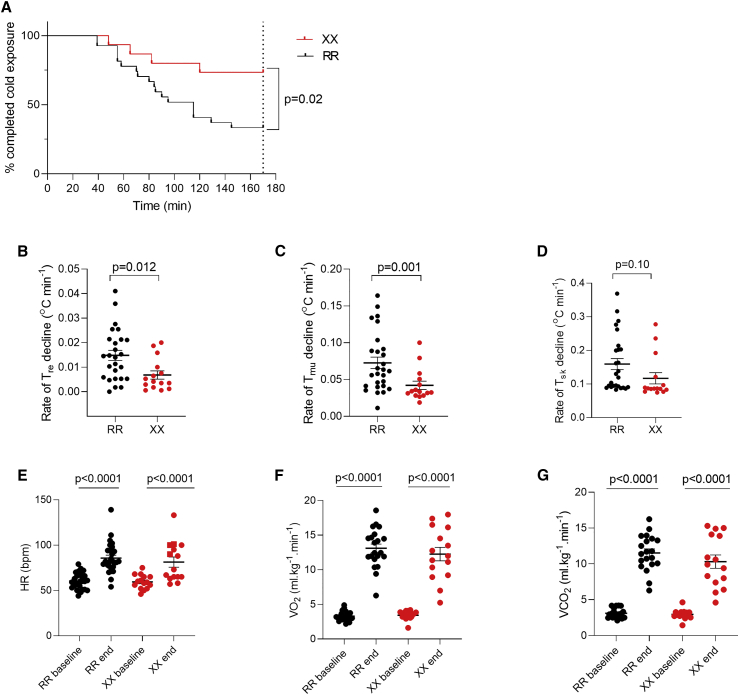
Temperature measurements and physiological responses during cold-water immersion(A) Survival plot of the time taken to reach a rectal temperature (Tre) of 35.5°C or sustaining the complete 170 min period of cold-water immersion in RR (n = 27) and XX (n = 15) individuals. Log-rank (Mantel-COX) test was used to assess statistical difference between RR and XX individuals.(B–D) The decline rate in rectal (Tre), intramuscular (Tmu), and skin (Tsk) temperatures in RR and XX subjects. Statistical difference between the two groups was assessed with unpaired t test.(E–G) Heart rate and rate of pulmonary O2 uptake (VO2) and CO2 exhalation (VCO2) before (baseline) and at the end of cold-water immersion in RR and XX subjects. Statistical assessment with 2-way RM ANOVA revealed no differences between the two groups either before or at the end of cold-water exposure. Plots show values for each RR (black circles) and XX (red circles) individual and mean ± SEM.